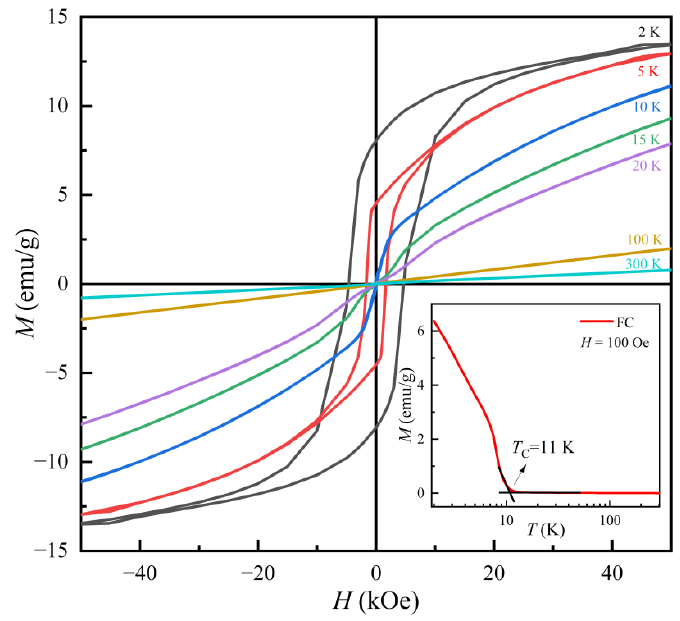
Figure 9. Hysteresis loops of (Fe 2 Se 3 ) 2 [Fe(dien) 2 ] 0.9 hybrid rods measured at different temperatures. Inset shows temperature dependence of FC magnetizations in a magnetic field H = 100 Oe.